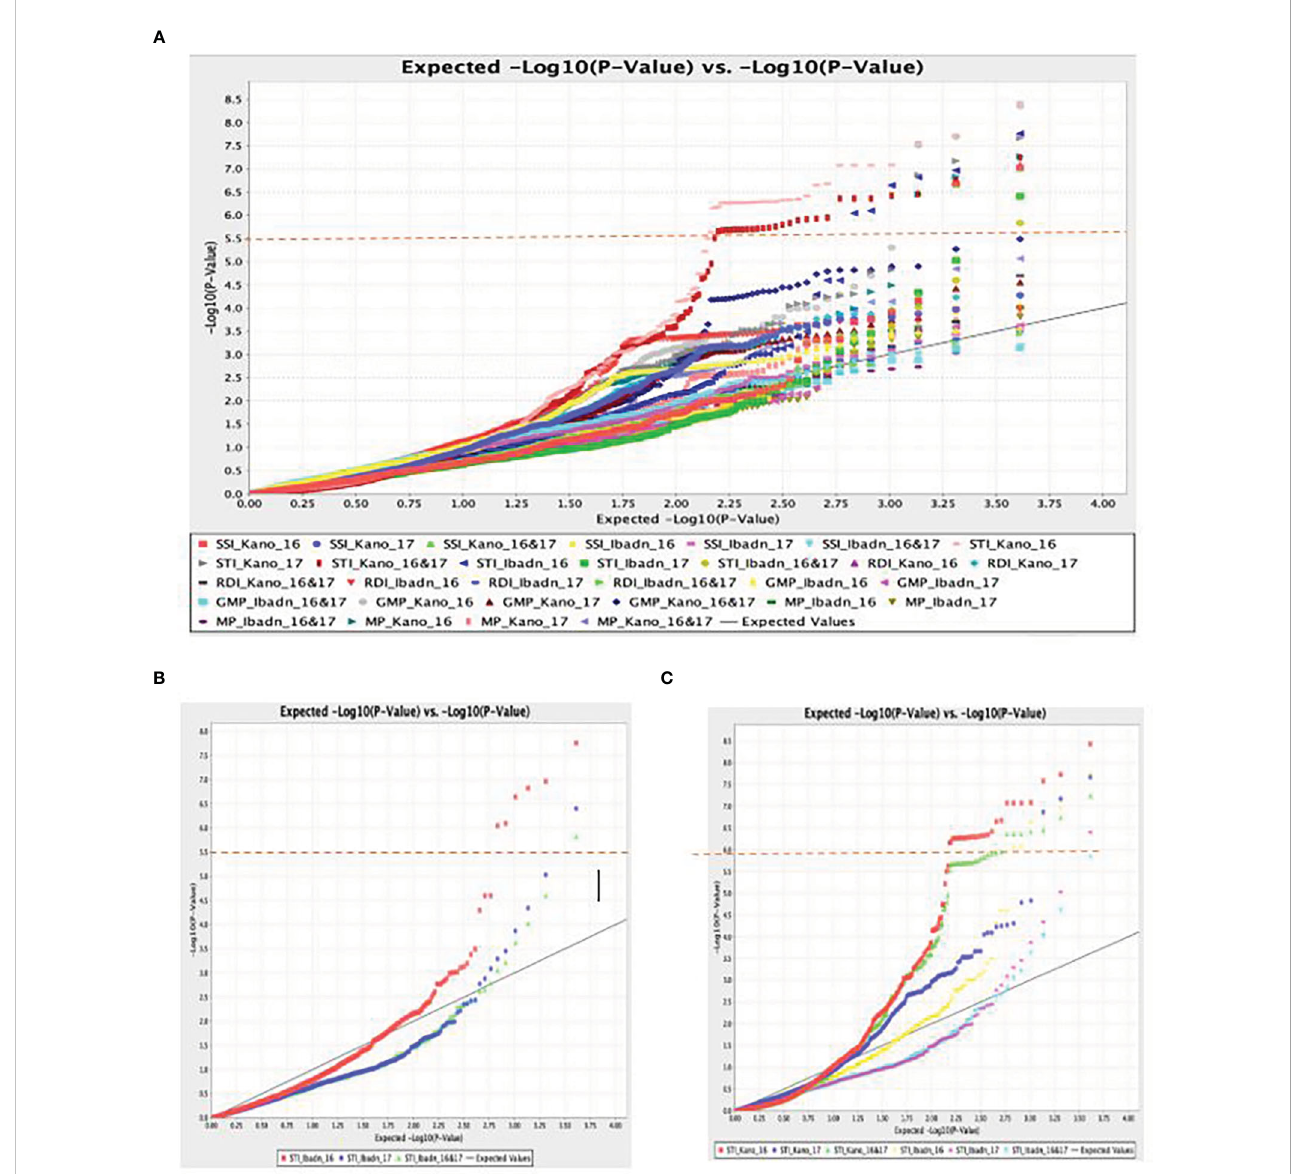
FIGURE 5 (A) Quantile – quantile (Q-Q) plot of a mixed linear model for Stress Tolerant Indices (STI) for drought studies in a panel of accessions of Bambara groundnut. (B) The p values of the SNPs and Quantile – quantile (Q-Q) plot of p values for stress-tolerant indices under the two water regimes in Ibadan. (C) The p values of the SNPs and Quantile – quantile (Q-Q) plot of p values for stress-tolerant indices under the two water regimes in Kano for the two